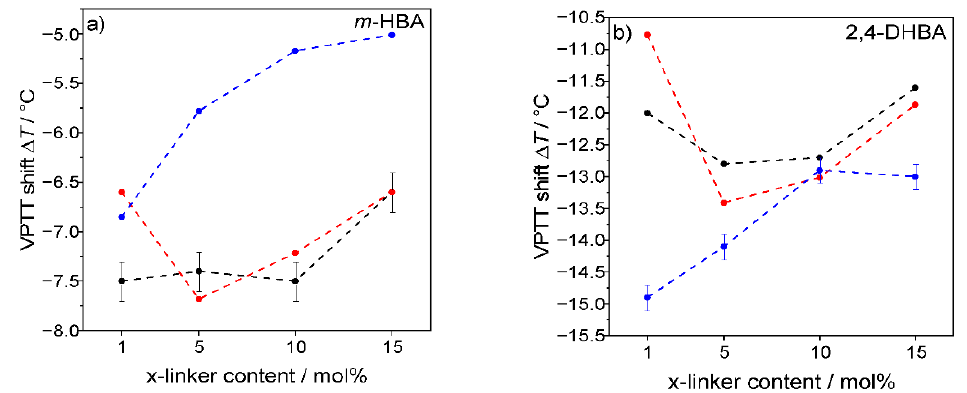
Figure 4. VPTT shift Δ T for different methods as a function of crosslinker content, as induced by the presence of ( a ) 20 mM m -HBA and ( b ) 2,4-DHBA as additives. Microgel concentrations are 1 wt.% (1 × 10 − 3 wt.% for DLS). Error bars reflect the standard deviation. The color code corresponds to different methods (DSC = red; DLS = blue; NMR = black).